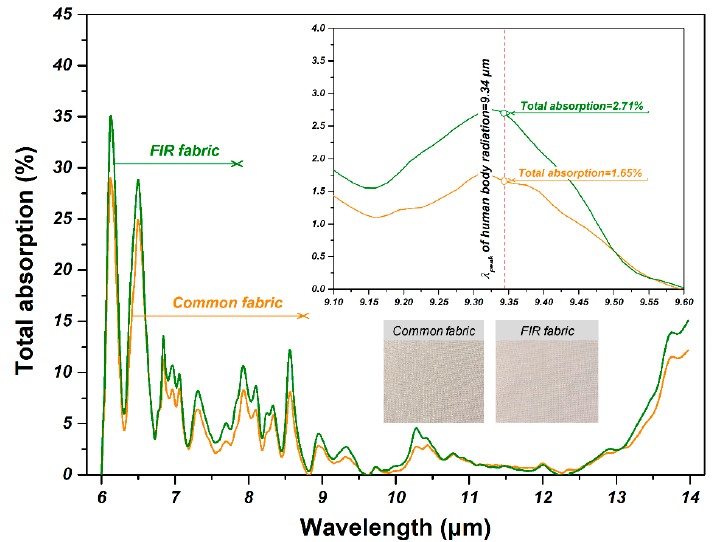
Figure 2. The FT-IR spectra of common fabric and FIR fabric in the range of 6 to 14 μ m.